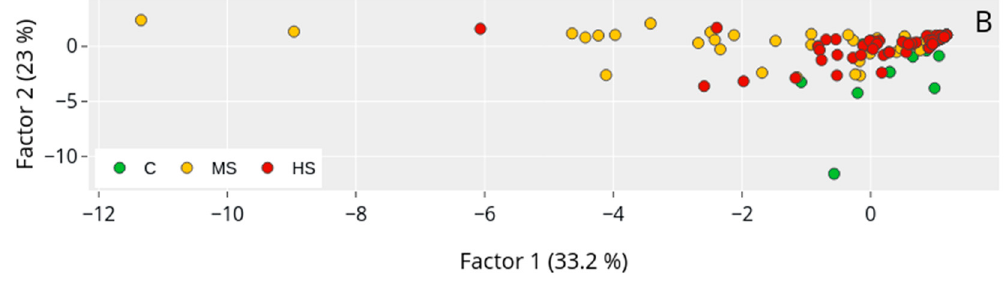
Figure 10. The relation between Factors 1 and 2, ( A ) Variables, and ( B ) Cases. TN, total nitrogen; C, control; MS, moderate severity; HS, high severity.